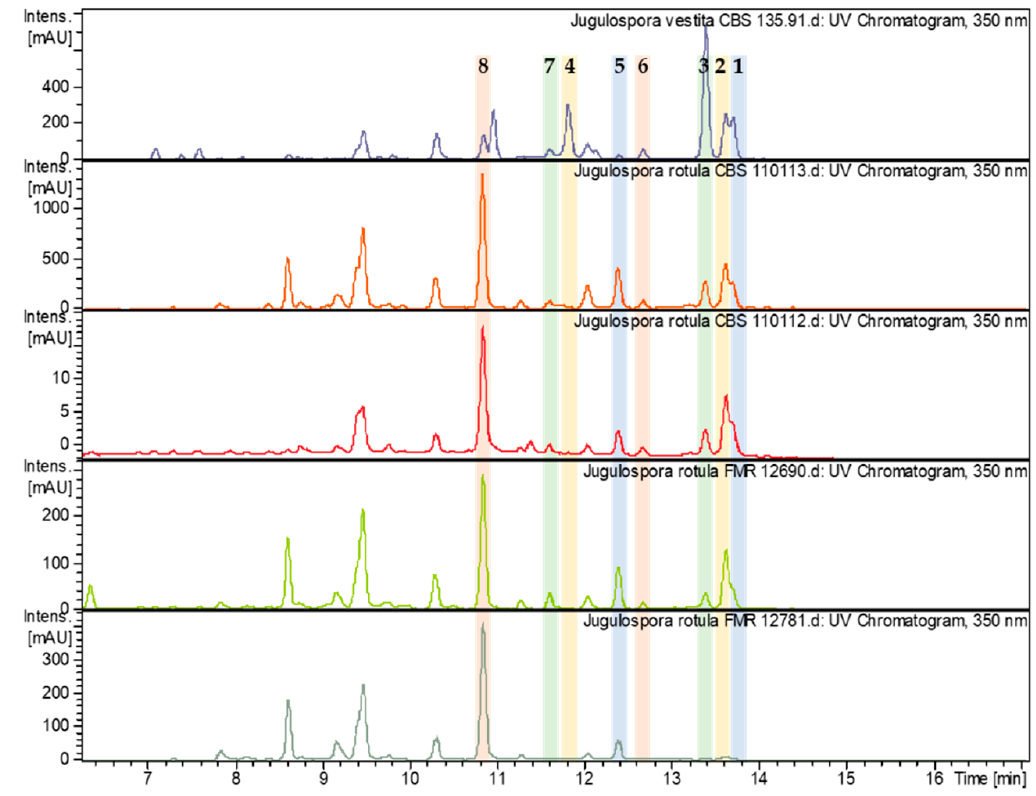
Figure 3. High performance liquid chromatography (HPLC) chromatograms (350 nm) of the ethyl acetate (EtOAc) extracts from the screened strains belonging to the genus Jugulospora with peaks of xanthoquinodins indicated by bold numbers referring to the molecules depicted in Figure 1.